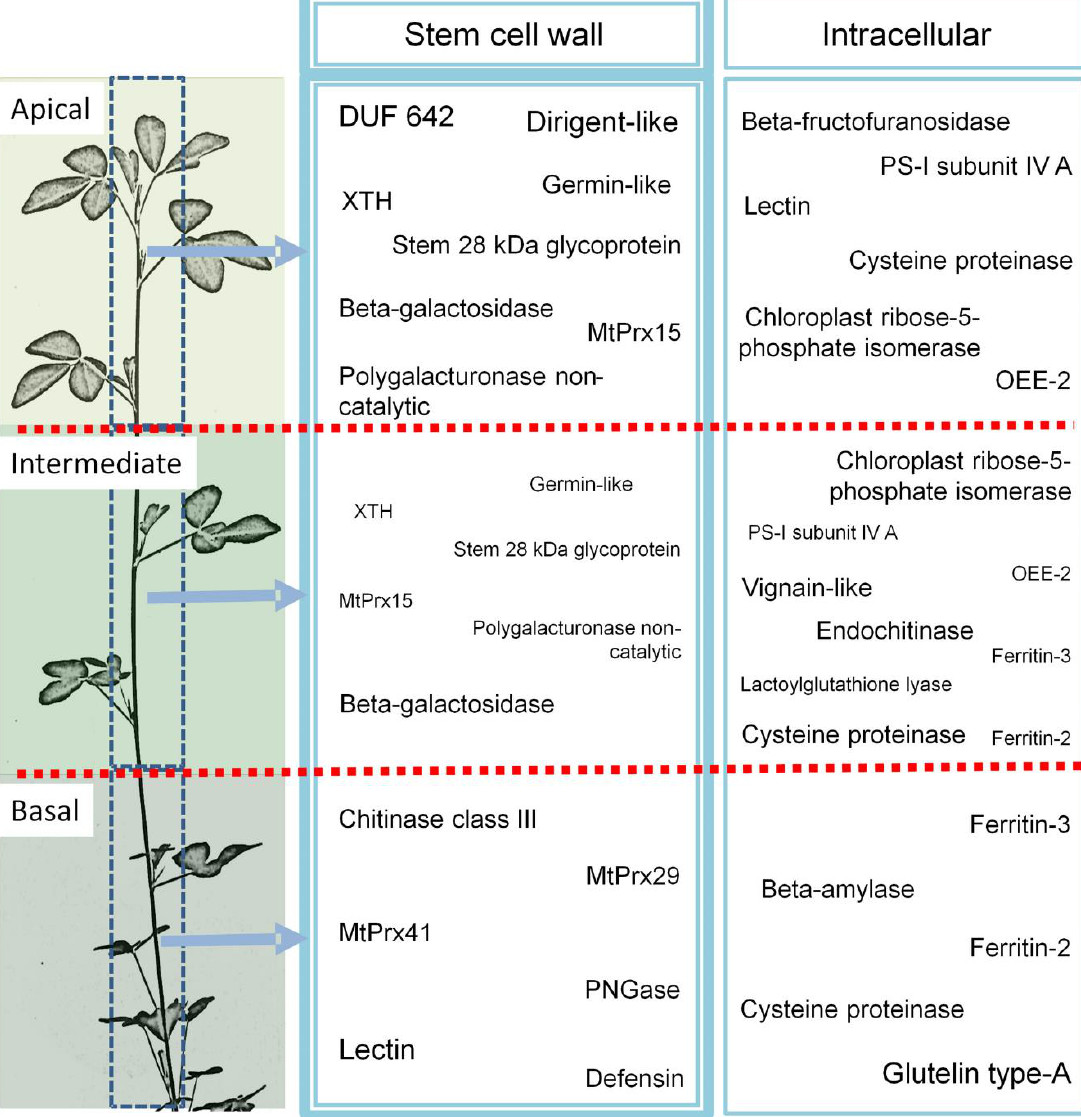
Figure 2. Profiling of the CWP and non-CWP (intracellular) discussed in this study and identified in the apical, intermediate, and basal stem region (big font size = high abundance, medium font size = medium abundance).